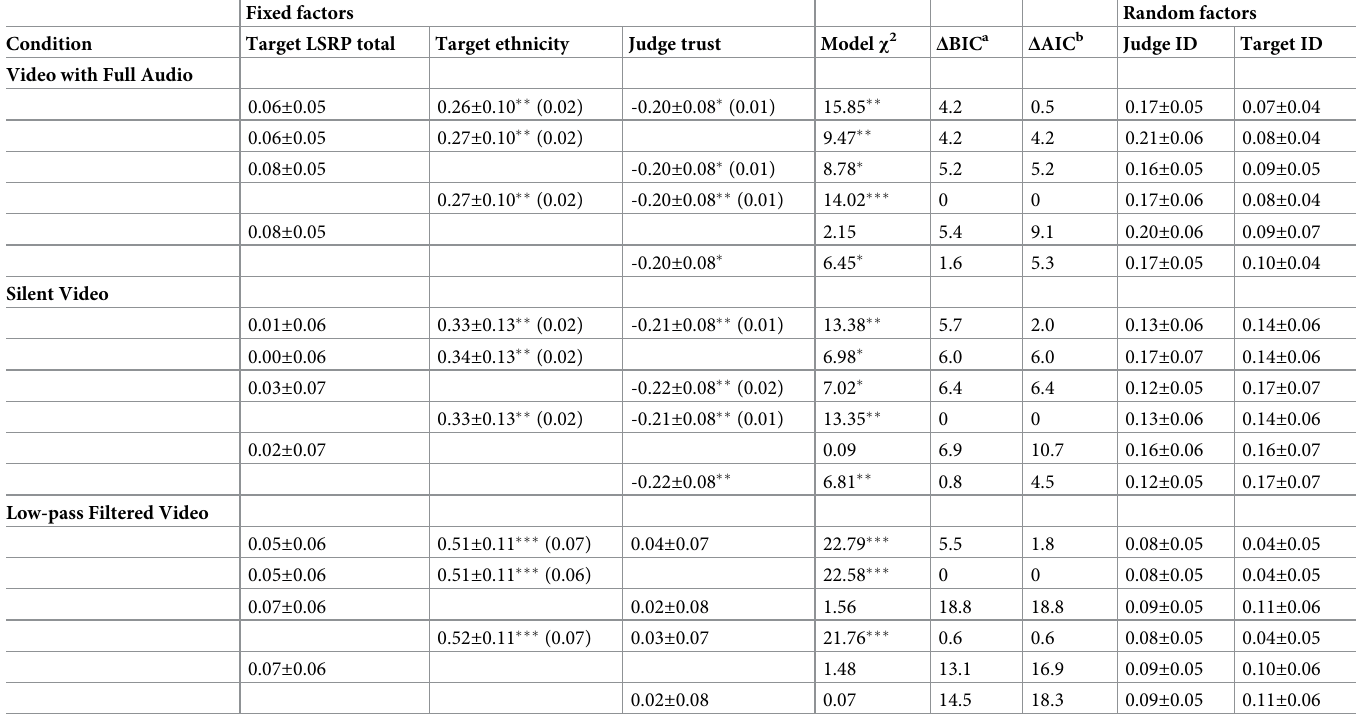
Table 6. Multilevel mixed regression models predicting Levenson other-report total psychopathy